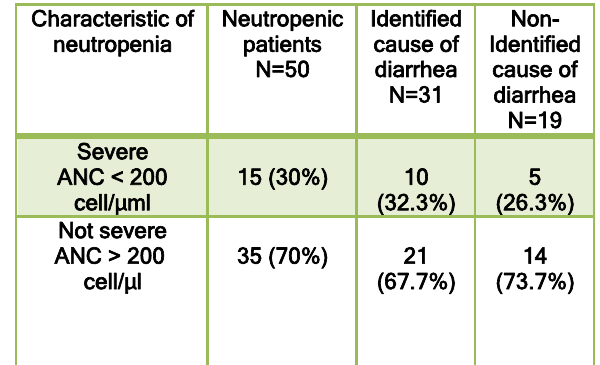
Fig. 2: Distribution of diarrheal cases according to gender of the patients. No statistically significant difference in the infection rates between males and females (p > 0.05). Table 2: Association between severity of neutropenia and type of